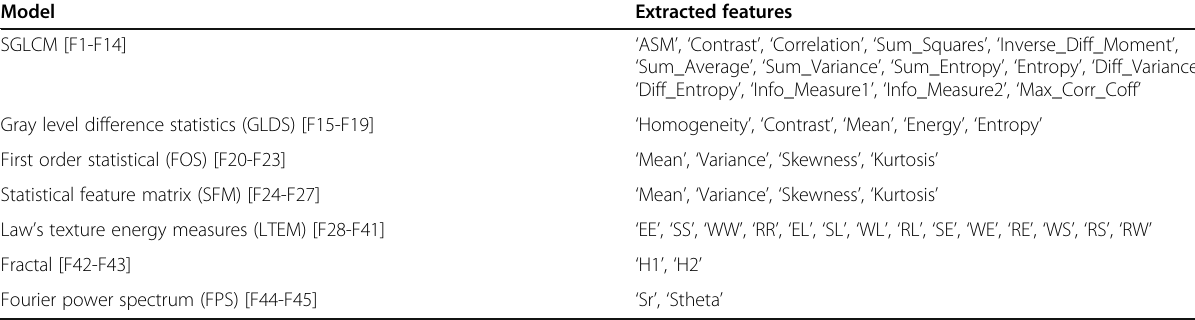
Table 2 Features extracted using different texture models Model Extracted